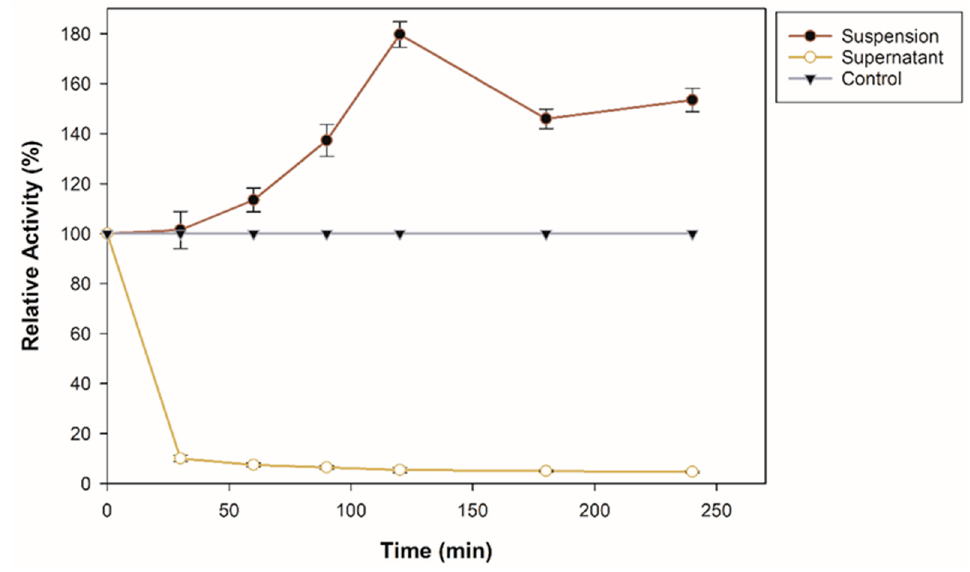
Molecules 2022 , 27 , x FOR PEER REVIEW 7 of 15 Figure 1. Immobilization course of recombinant β -glucosidase on zeolite at pH 8, 25 °C, and shaking.